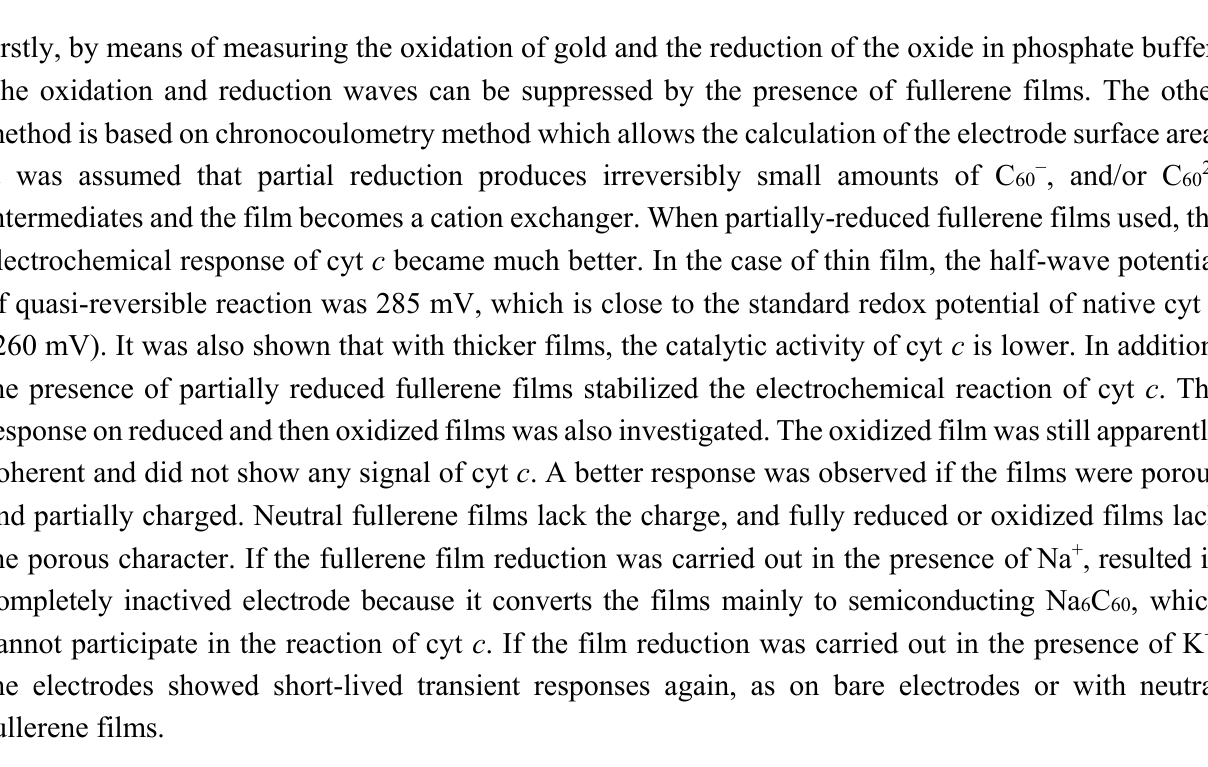
Table 1. Comparison of different fullerene-C 60 modified